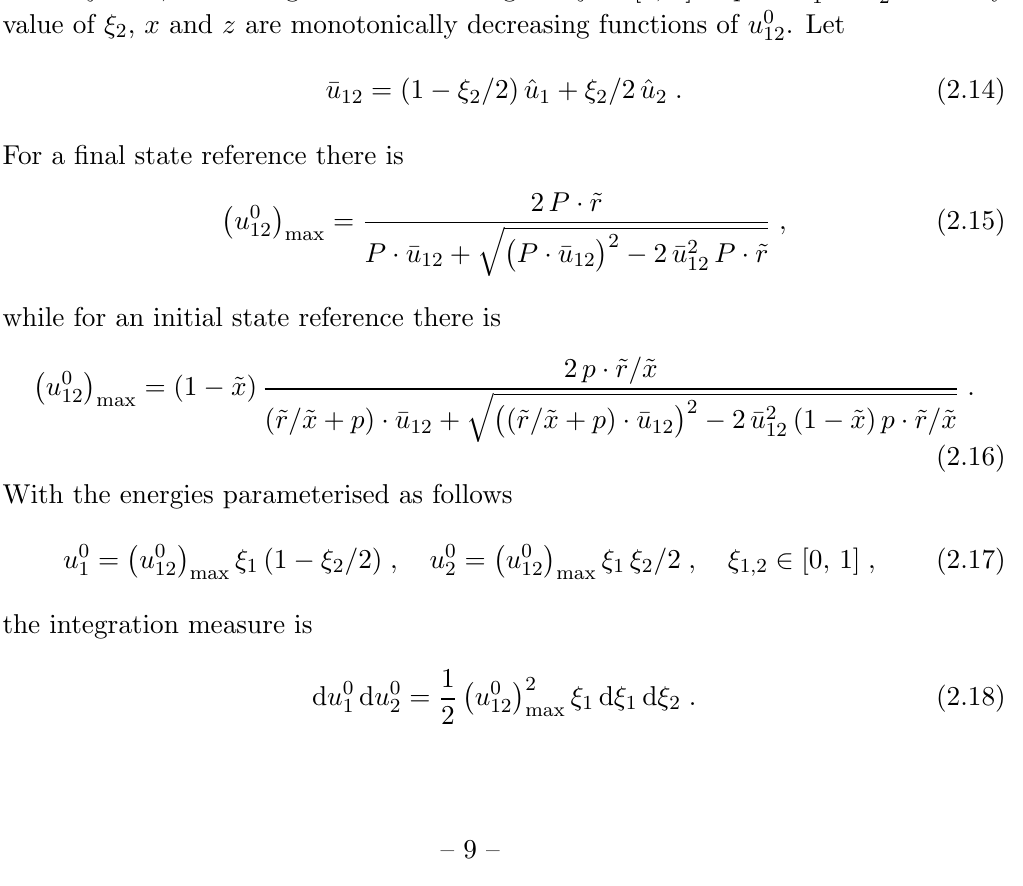
2. The function (cid:22) (cid:24) 2 is de(cid:12)ned $